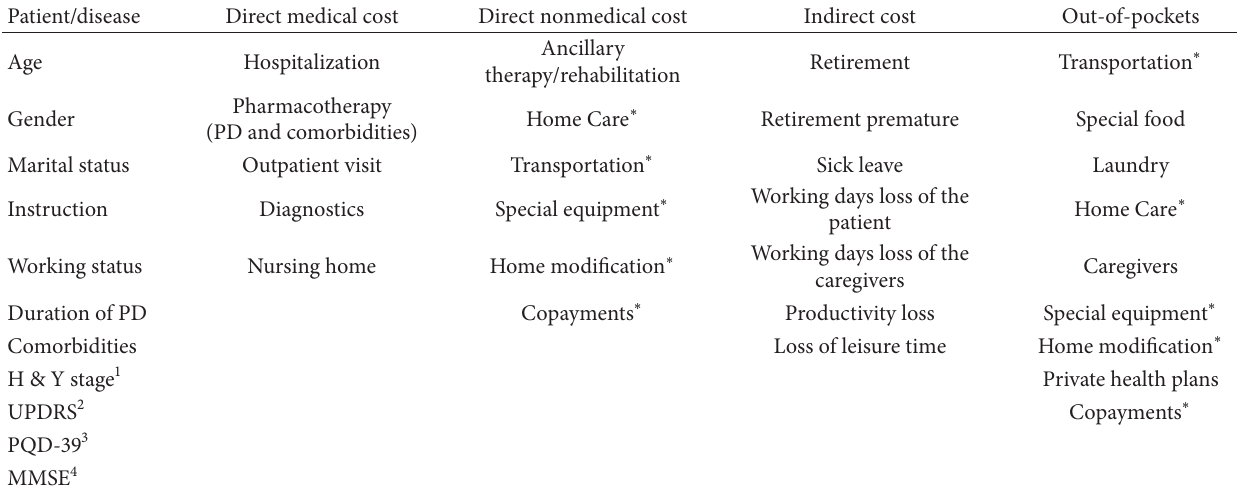
Table 6: Most common variables found in the cost studies of Parkinson’s